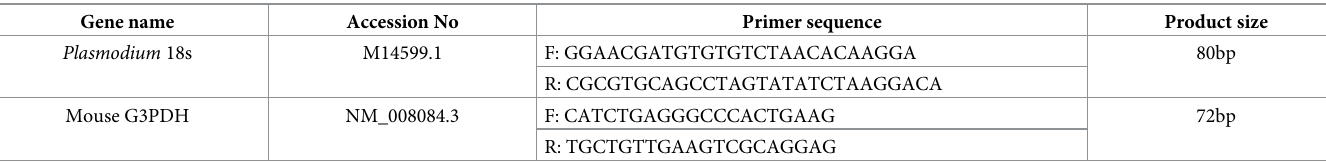
Table 1. Information for PCR